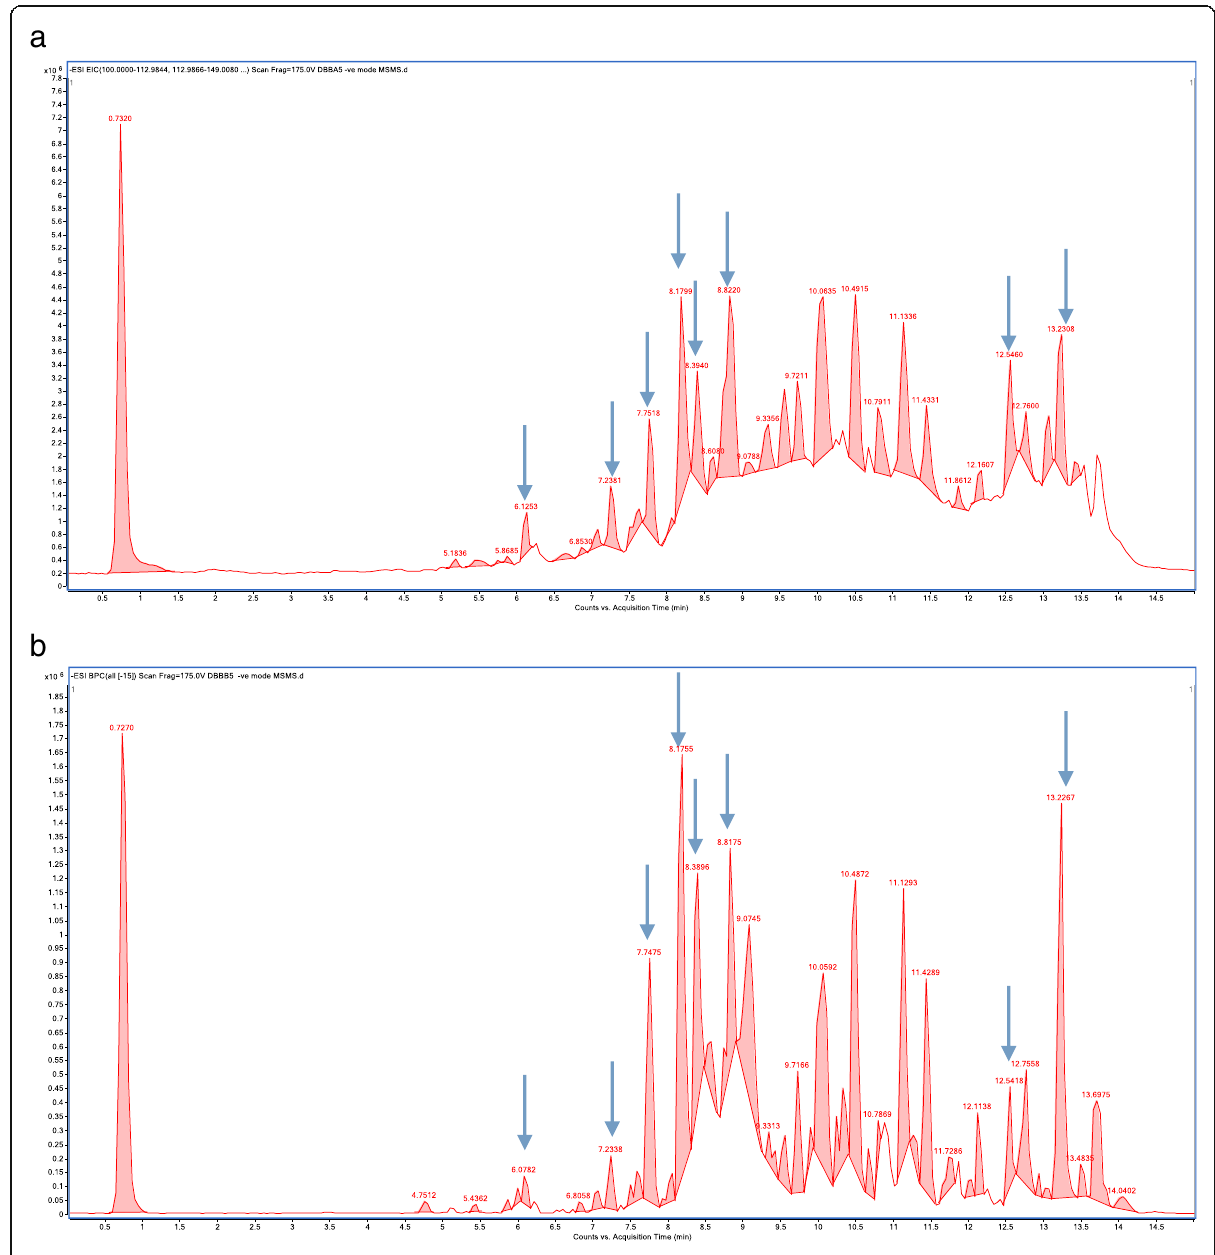
Fig. 6 LC-MS Chromatograms of two batches of DBB extract A & B. Blue arrows indicate similar peaks obtained from the two different